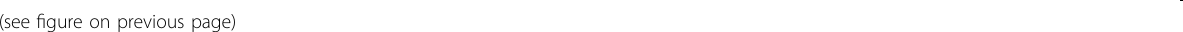
Fig. 3 NAC treatment improved pulmonary fi brosis in Bmi-1 − / − mice more than in Bmi-1 − / − p16 − / − mice. a Representative micrographs of paraf fi n-embedded pulmonary sections stained histochemically for Masson ’ s trichrome (Masson), immunohistochemically for α -smooth muscle actin ( α -SMA), type Ι collagen (collagen 1), fi bronectin, TGF- β 1 and IL-11, and immuno fl uorescently for IL-11 receptor α 1 (R α 1) and SFTPC, with DAPI staining the nuclei. b Percentage of cells positive for Masson, α -SMA, collagen 1, fi bronectin, TGF- β 1, IL-11, IL-11R α 1, or SFTPC or positive areas relative to the total cells or areas. c Col1a1 , Col1a2 , ACTA2 , plasminogen activator inhibitor-1 ( PAI-1 ), TGF- β 1 , matrix metalloproteinases ( MMP9 ), MMP12 , IL-11 and IL-11R α 1 and SFTPC mRNA levels in lungs by real-time RT-PCR, calculated as the ratio to β -actin mRNA and expressed relative to that of WT. Six mice per group were used for experiments. Values are the mean ± SEM from six determinations per group. * P < 0.05, ** P < 0.01, *** P < 0.001 compared with the WT group; # P < 0.05, ## P < 0.01, ### P < 0.001 compared with the Bmi-1 − / − group; & P < 0.05, && P < 0.01 compared with the Bmi-1 − / − p16 − / −